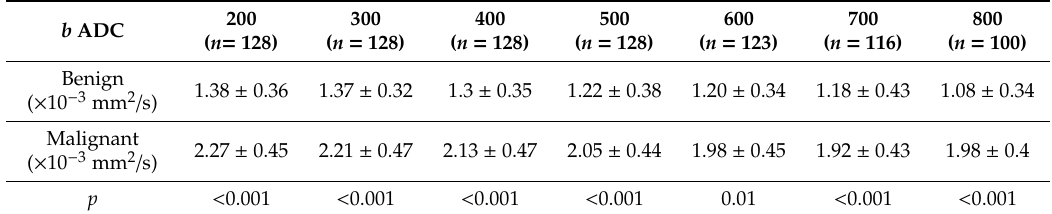
Table 1. Compare mean ADC value of two groups: malignant and benign lesions with di ff erent b-value on Di ff usion Weighted MRI.